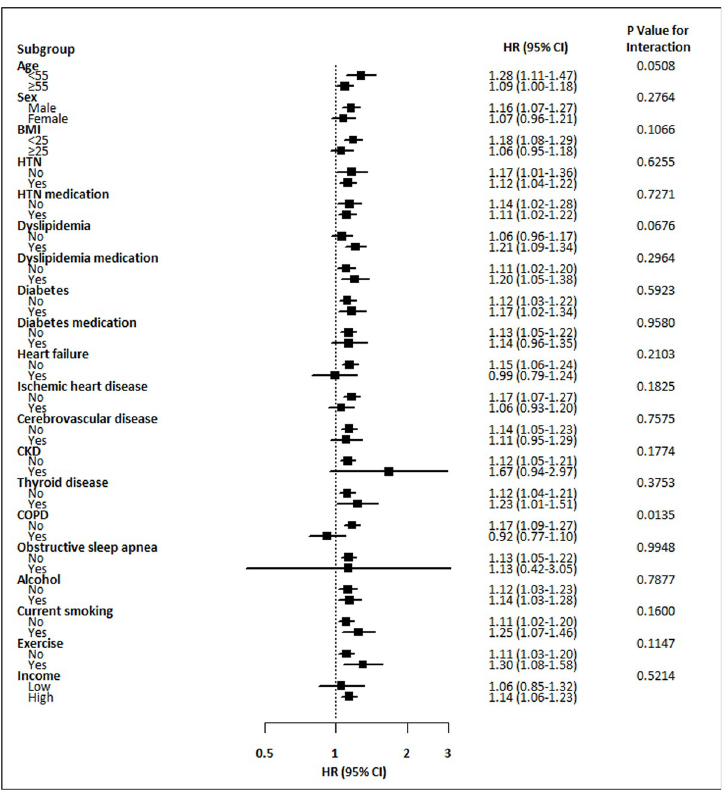
Fig 4. Hazard ratios and 95% confidence intervals for the risk of AF in the highest quartile vs. lower three quartiles of TC variability (TC-CV) in subgroups. Abbreviations: AF, atrial fibrillation; BMI, body mass index; CKD, chronic kidney disease; COPD, chronic obstructive pulmonary disease; CV, coefficients of variance; HTN, hypertension; TC, total cholesterol.